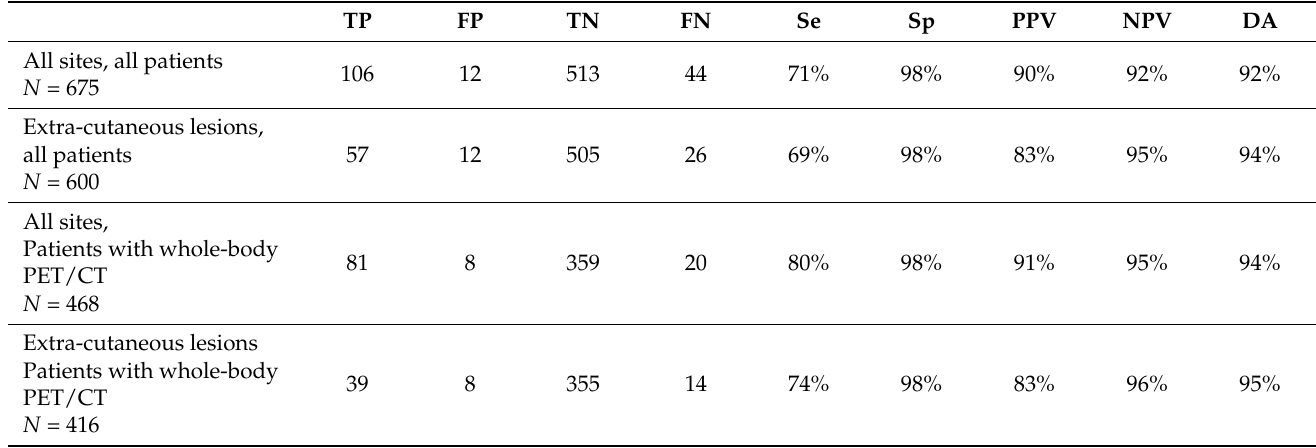
Table 4. Per lesion analysis of diagnostic performance for FDG PET/CT.